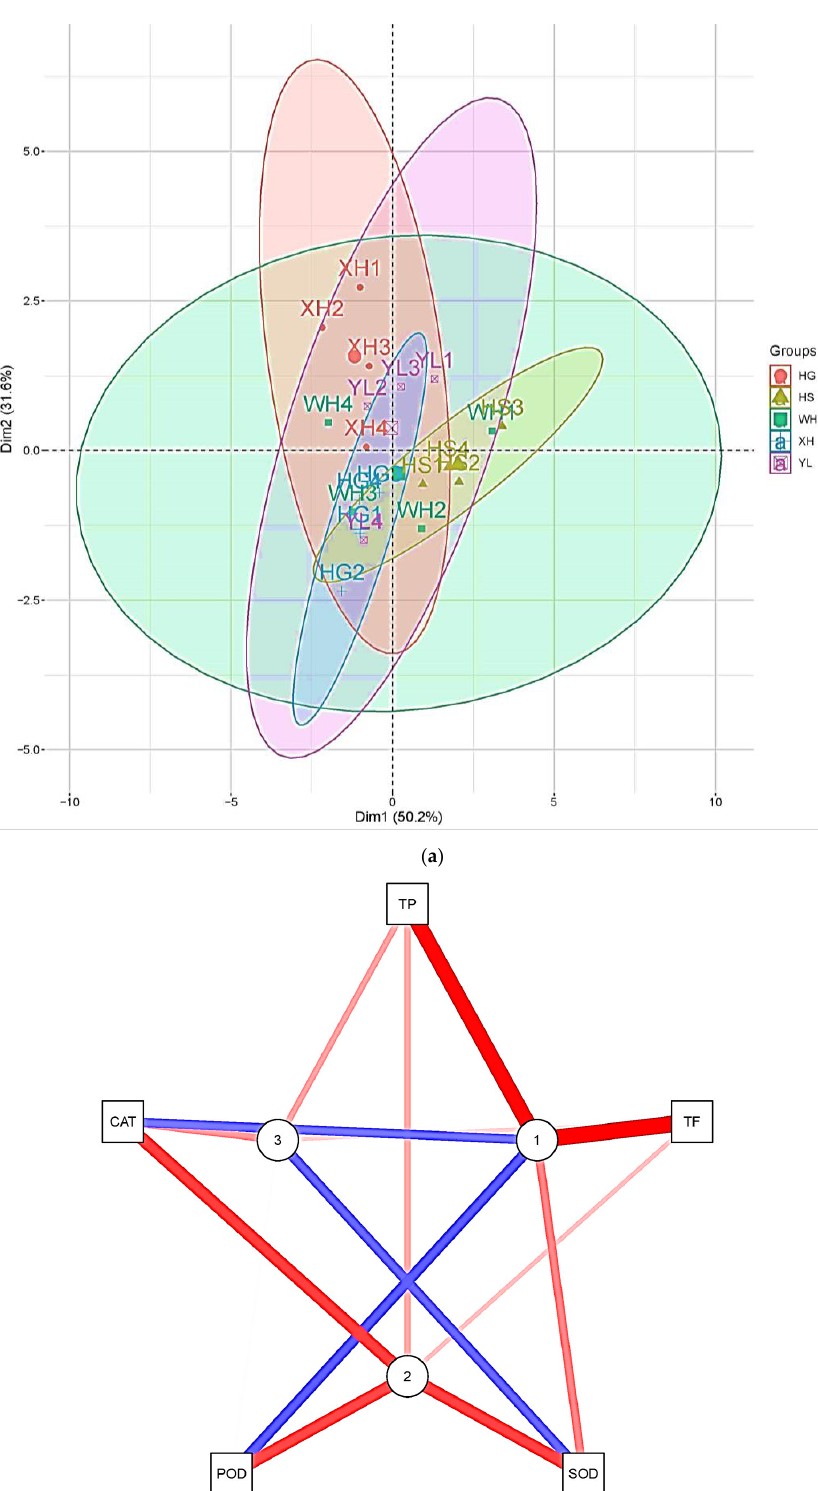
Figure 5. PCA of five pear cultivars. ( a ) Cultivars scores scatter plot. The number behind the cultivars name represents different shelf life, and 1 – 4 represents 0 d, 10 d, 20 d, 30 d, respectively. The ellipse size indicates the degree of variation within the group. ( b ) The loadings network diagram of PCA. The graph shows the magnitude of the principal component load in the form of a network diagram. TP: total polyphenol, TF: total flavonoids. The thickness of the line indicates the magnitude of the value. Red is positive and blue is negative.